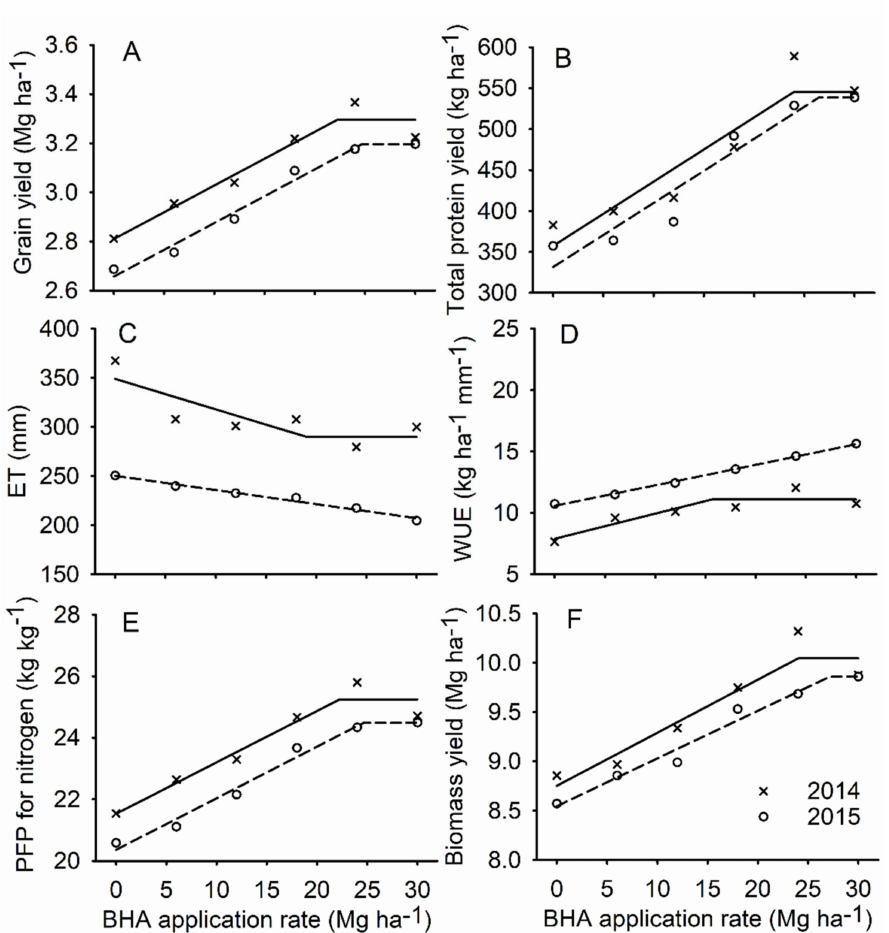
Figure 4. Relationships between the one-time bentonite-humic acid (BHA) application in 2011 and ( A ) grain yield (GY), ( B ) total grain protein yield (TGP), ( C ) evapotranspiration (ET), ( D ) water use efficiency (WUE), ( E ) partial factor productivity of nitrogen (PFPN), and ( F ) biomass yield (BY) in 2014 and 2015. The response of dependent variable (Y) to the BHA application rate (X) for each year was fitted to separate piecewise linear plus plateau models (dotted lines). The slopes of the regression lines were significant ( p < 0.05) for all